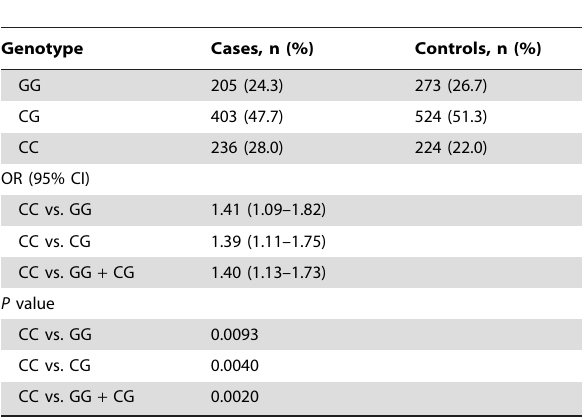
Table 1. Risk of NPC associated with the BIRC5 -31C/G polymorphism in the Guangxi